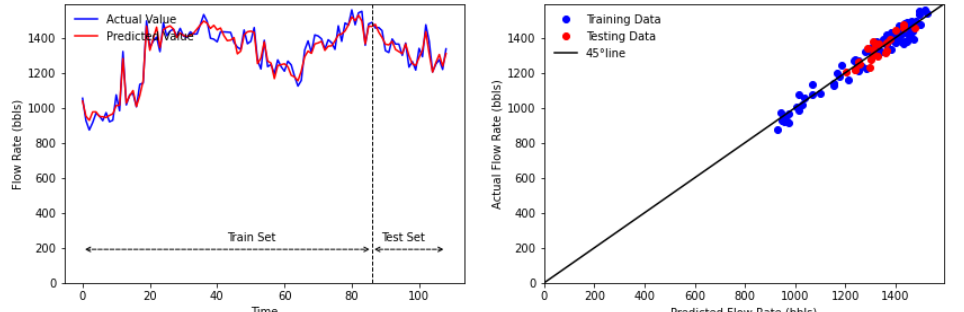
Figure 7. Prediction result of EMD-BP-MLMVN for CS18.